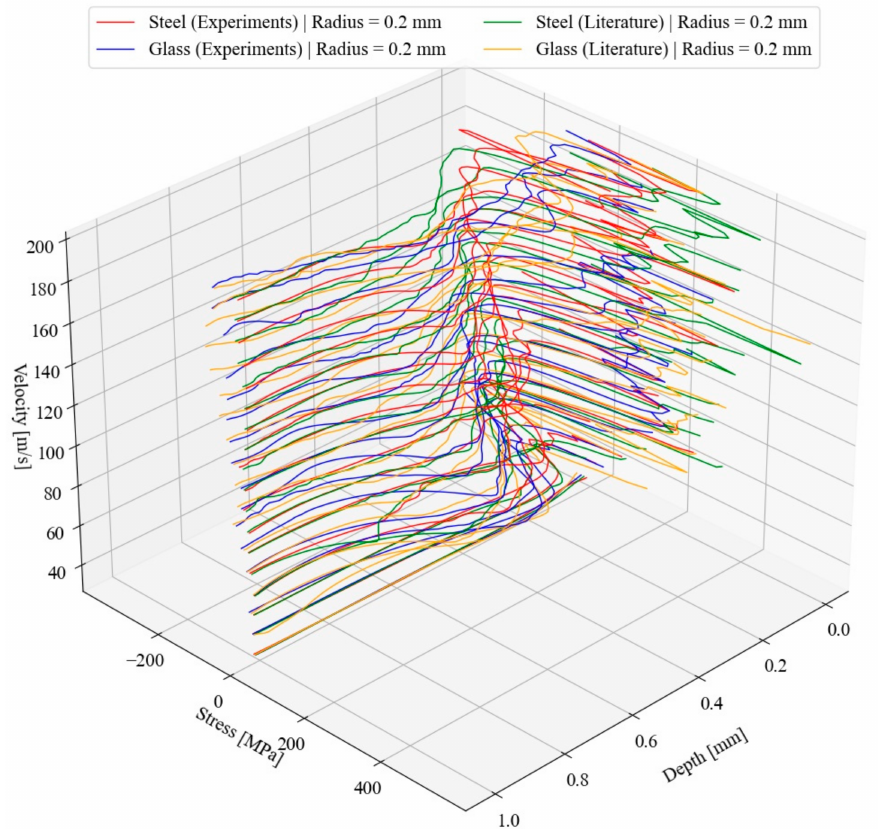
Figure 6. Resulting residual stress profile for a defined sphere diameter (0.4 mm) for the JC parameters obtained experimentally (steel spheres (red), glass beads (blue)) and alternative parameters derived from [53] (steel spheres (green), glass beads